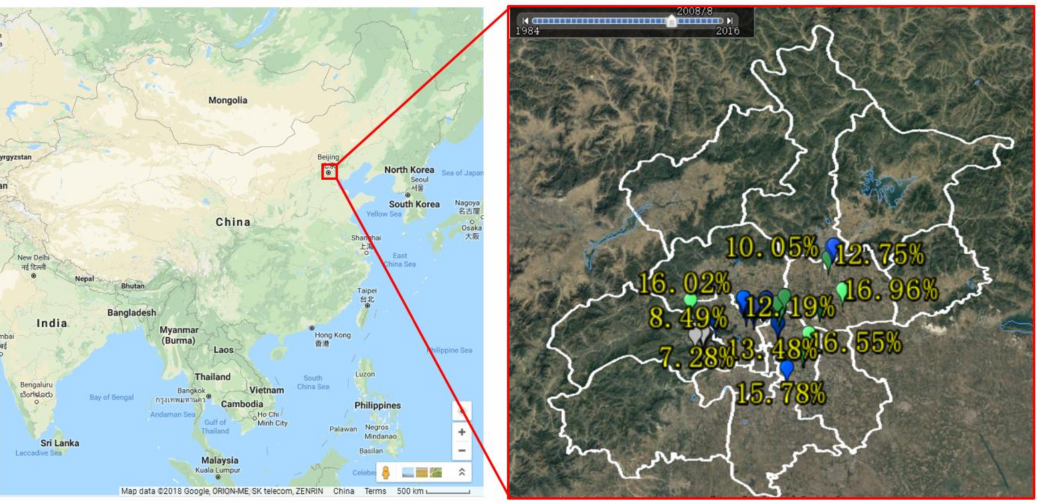
Figure 1. The 50 position points of the selected samples for lab tests.